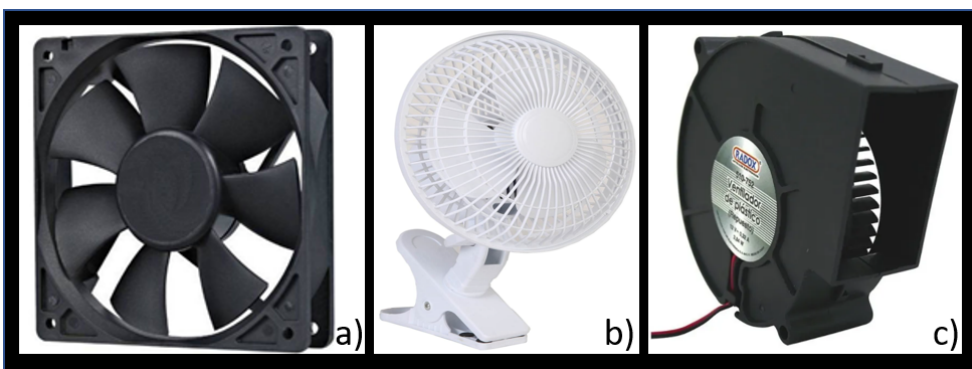
Figure 4. Wind sources as the exogenous disturbance input. ( a ) Computer fan, ( b ) mini desktop fan, ( c ) air